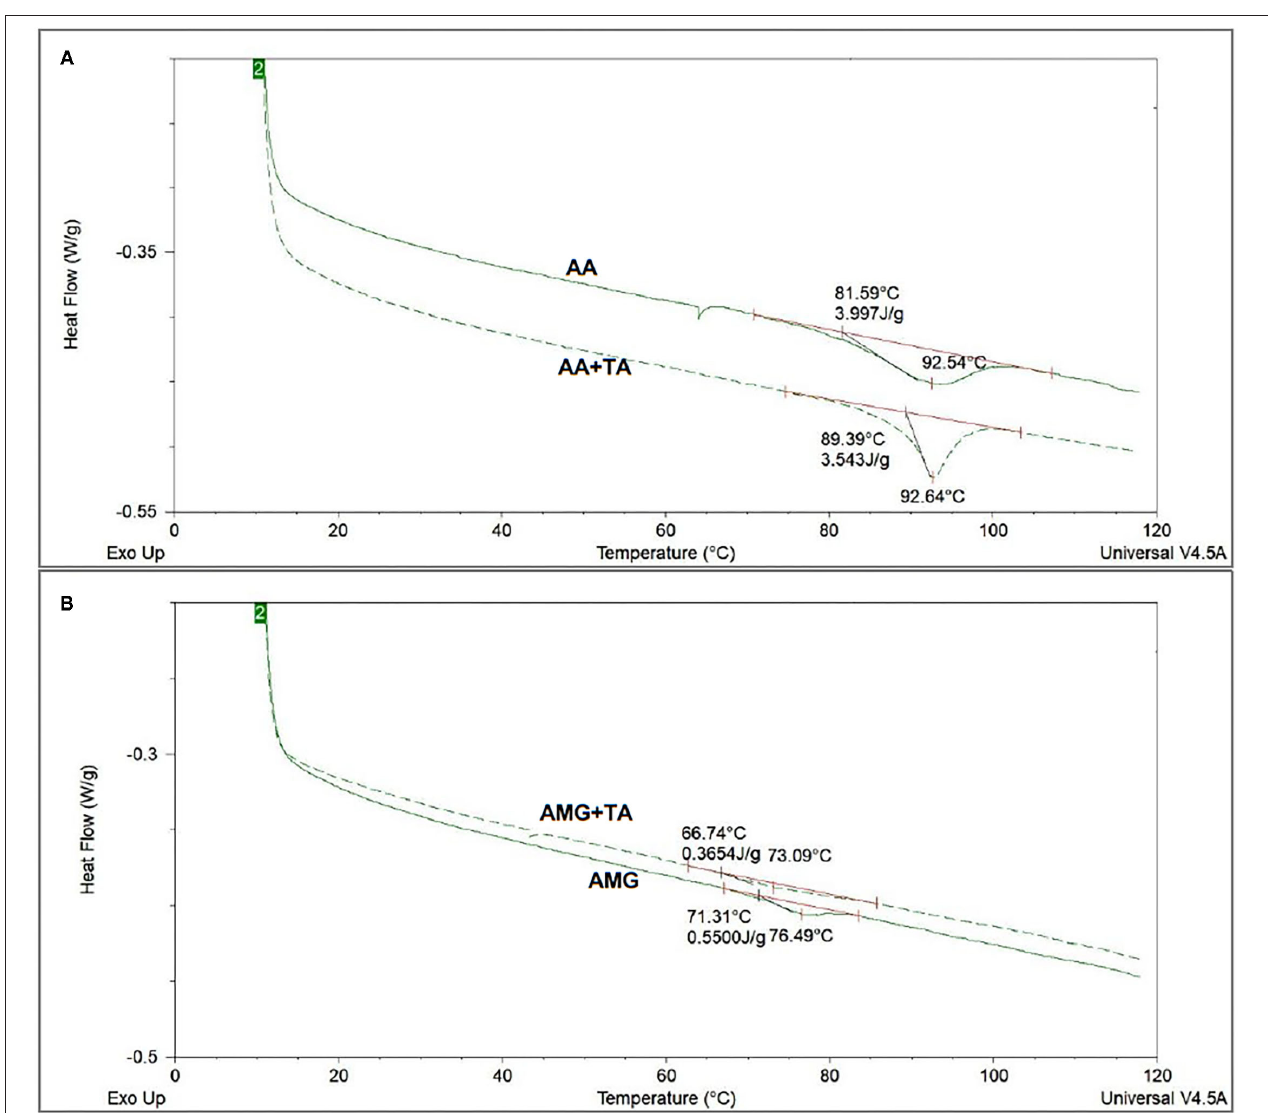
FIGURE 5 | The differential scanning calorimetry (DSC) thermograms of AA (A) and AMG (B) in the absence and presence of TA, in which the denaturation temperatures ( T d ) and denaturation enthalpy ( 1 H dsc ) were obtained after integration of the heat-flow